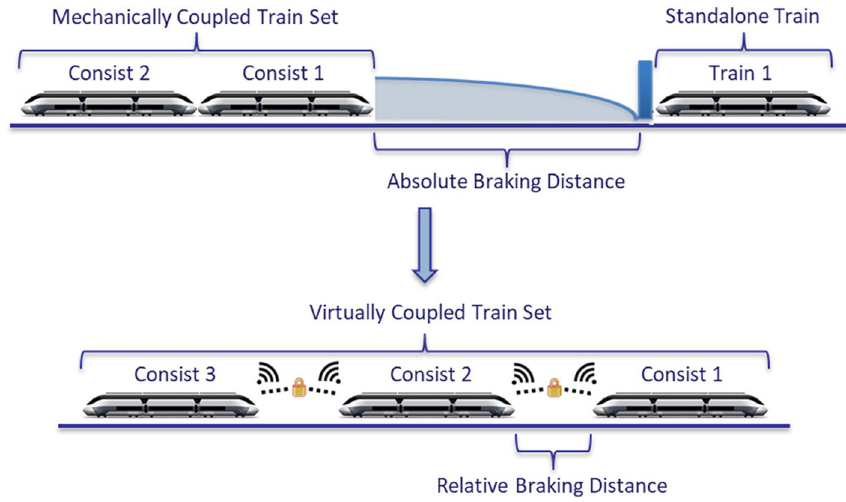
Figure 1. Overview of mechanically and virtually coupled train set paradigms and the shift from absolute to relative braking distance, exemplary representation as distances are larger in